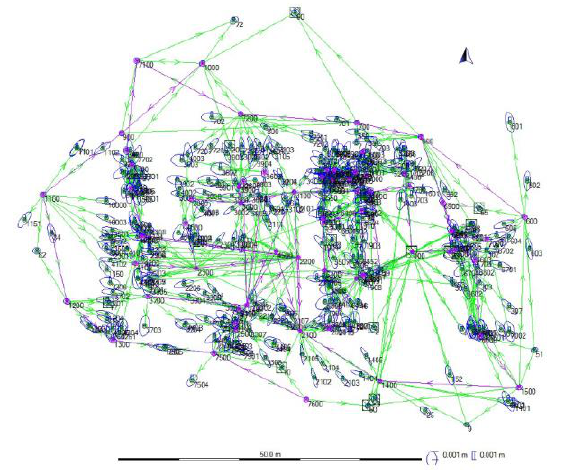
Fig. 2. The geodetic network measured with a total station Leica TS30 (the average precision is ±1.2 mm).